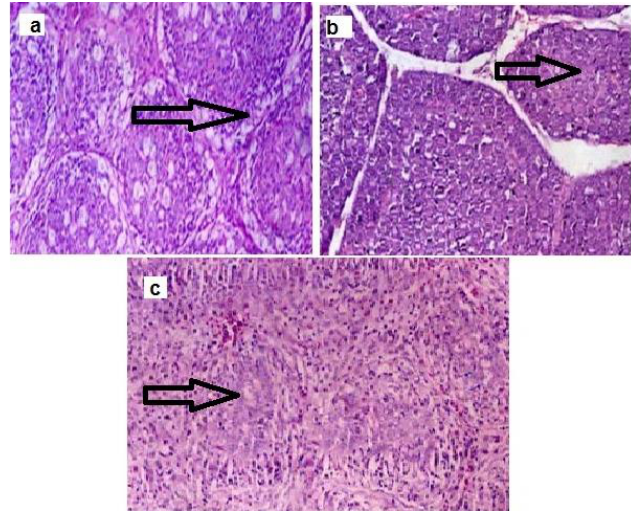
Figure 1. Histopathologic sections of bursae fibrisous from chicken naturally infected with IBDV (H&E 100 × ): a. Vacuolation of cystic lymphoid follicles and depletion with leukocytes infiltration. b. Atrophied bursal lymphoid follicles with inter-follicularedema. c. Complete follicular necrosis with cyst-like space containing